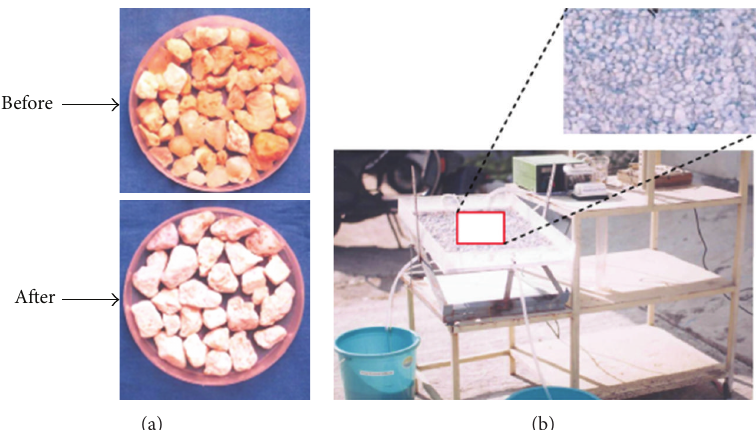
Figure 8: (a) Pebbles before and after TiO 2 coating, (b) solar photocatalytic pebble bed reactor, and the close-up of pebbles. (Figure 8 is reproduced from reference [28]. Copyright 2012, with permission from Elsevier).